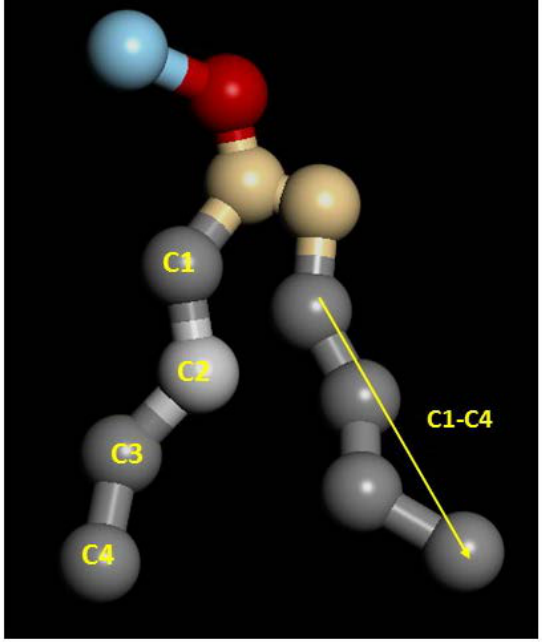
Figure 4. Numbering of beads used to calculate order parameters.